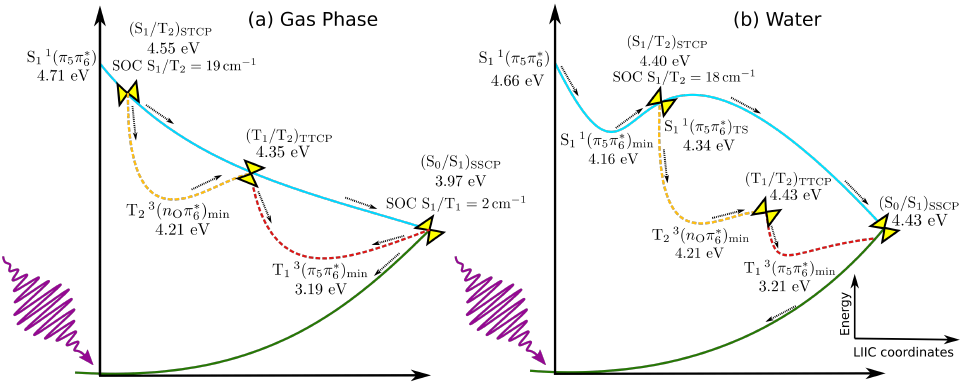
Figure 2. Schematic representation of the main photophysical events computed for 1CHU in ( a ) gas phase and ( b ) water. Energies in relation to the ground state optimized geometry are reported in eV, and the SOC values in cm − 1